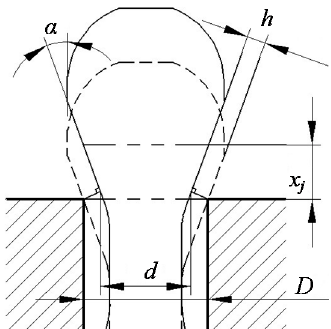
Figure 6. The relief valve spool relative position.